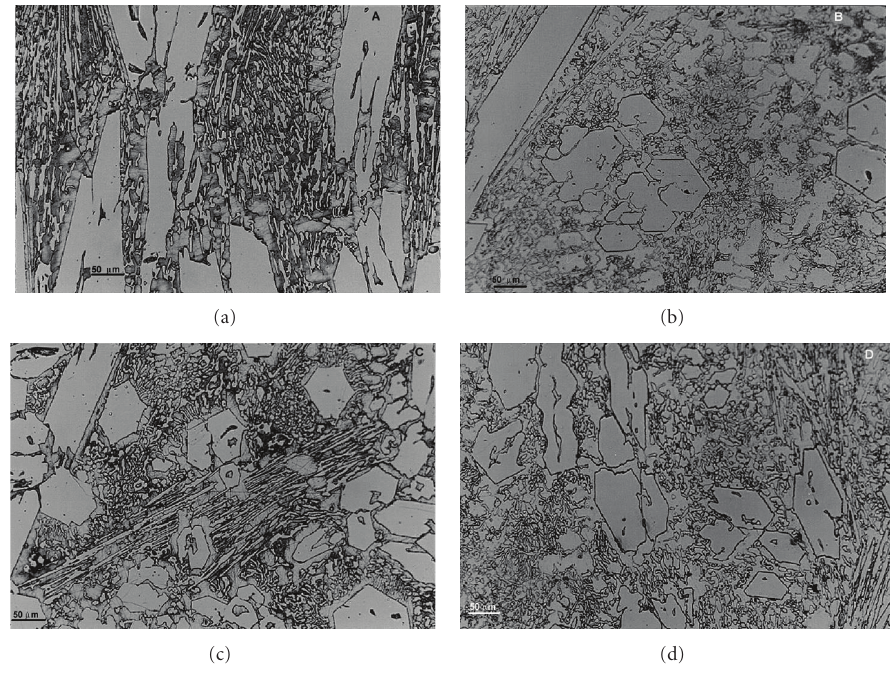
Figure 1: Microstructure of castings containing (a) 5.31, (b) 4.77, (c) 5.09, and (d) 4.06 C E .